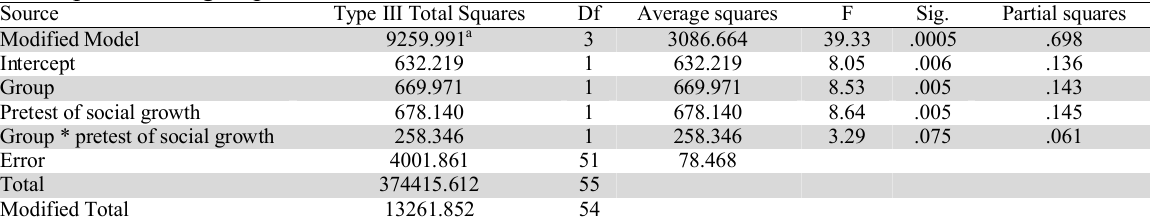
The results of one-way ANCOVA in dependent social growth variable in scores of posttest of control and experimental groups Source Type III Total Squares